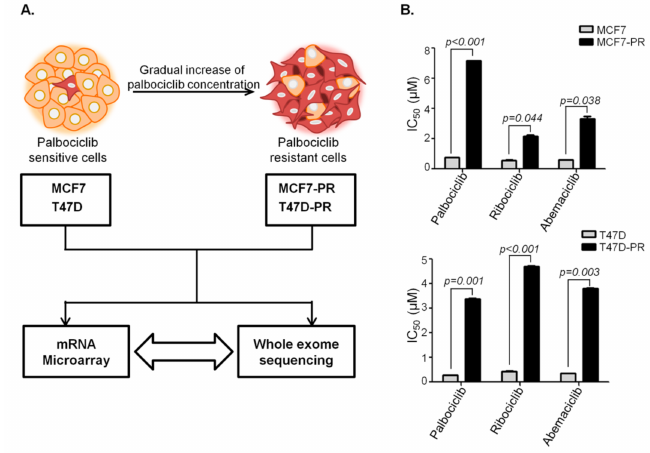
Figure 1. Schematic design of the current study. Generation of palbociclib-resistant cells. ( A ) Palbociclib-resistant HR-positive breast cancer cells, indicated as MCF7-PR and T47D-PR, were generated by gradually exposing MCF7 and T47D cells to increasing concentrations of palbociclib. ( B ) The IC50 of palbociclib in MCF7-PR and T47D-PR cells increased by around 10-fold. MCF7-PR and T47D-PR cells were cross-resistant to ribociclib and abemaciclib. P values were calculated by Student’s t -test. Data are presented as means ± standard deviation of triplicate experiments. Palbociclib-resistant cells and their sensitive counterparts were compared using microarray analyses and whole-exome